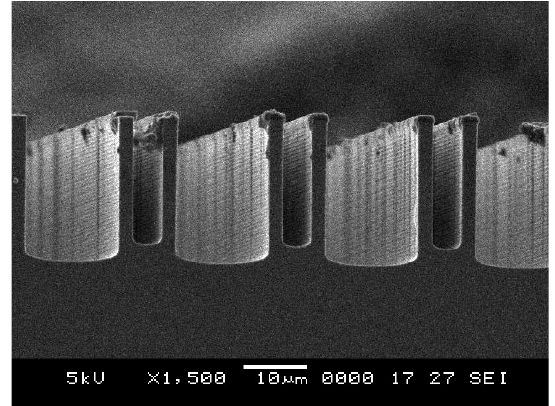
Figure 5. Scanning electron microscope (SEM) images of lag effect for unexpected Deep reactive-ion etching (DRIE) process results.